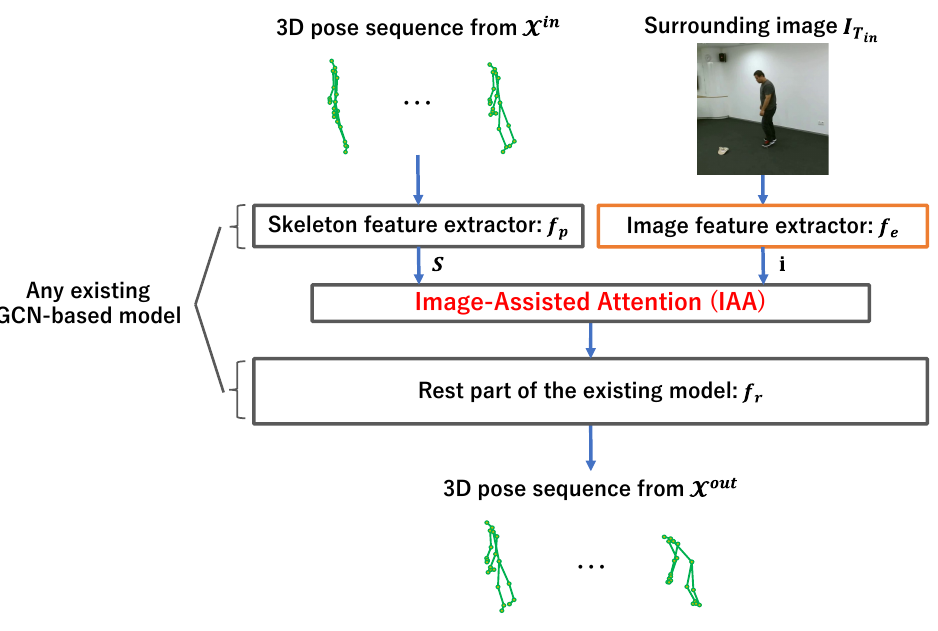
Figure 2. The proposed surrounding-aware future skeleton prediction framework. The skele- ton feature S is modified using the surrounding image feature i extracted from the human surrounding